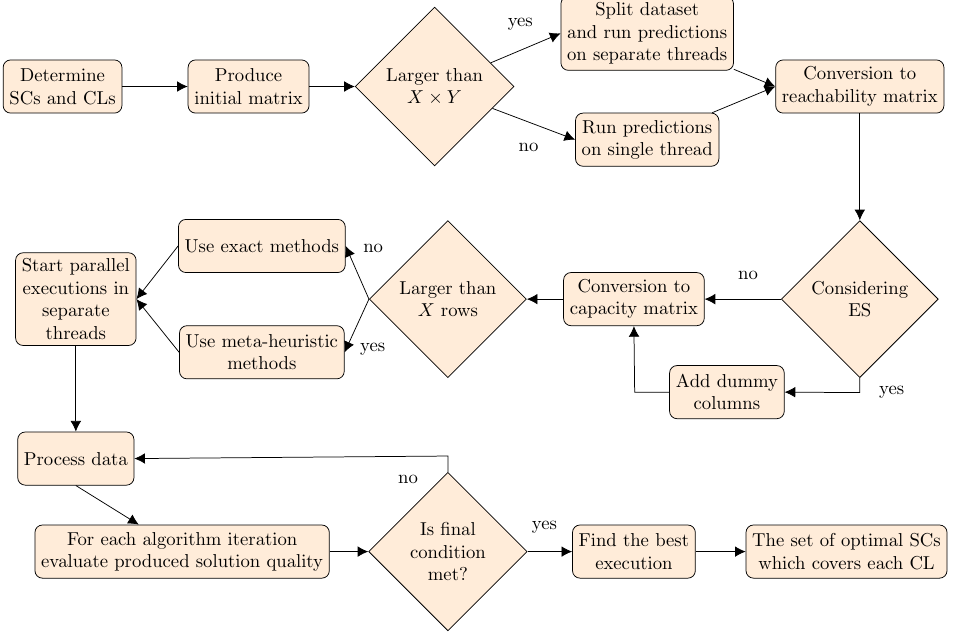
Figure 4. The basic concept of producing the optimal solution (SC: service centre, CL: customer location and ES: existing